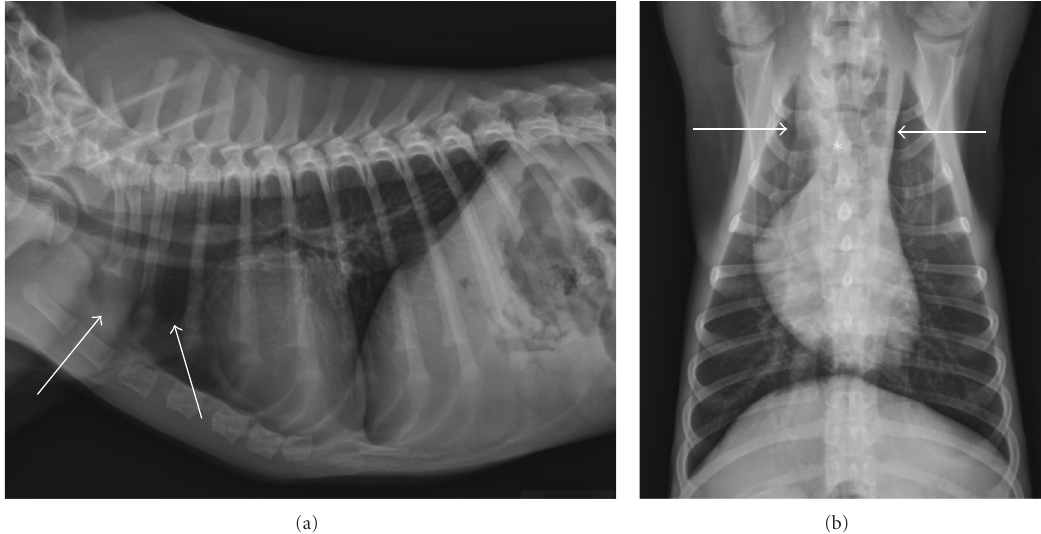
Figure 1: Right lateral (a) and ventrodorsal (b) radiographs of the thorax. A dilated mostly gas-filled structure (arrows) consistent with focal megaesophagus is present cranial to the cardiac silhouette on the lateral view (a). On the VD view (b) the aortic arch is located within the right aspect of the cranial mediastinum ( ∗ ), the trachea is displaced to the left at the level of the aortic arch, and there is mild widening of the cranial mediastinum (arrows).